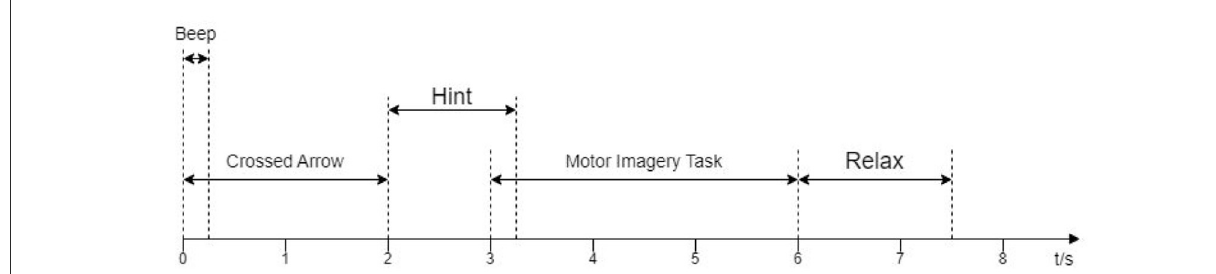
FIGURE1 The experimental protocol for the acquisition of Dataset 1.